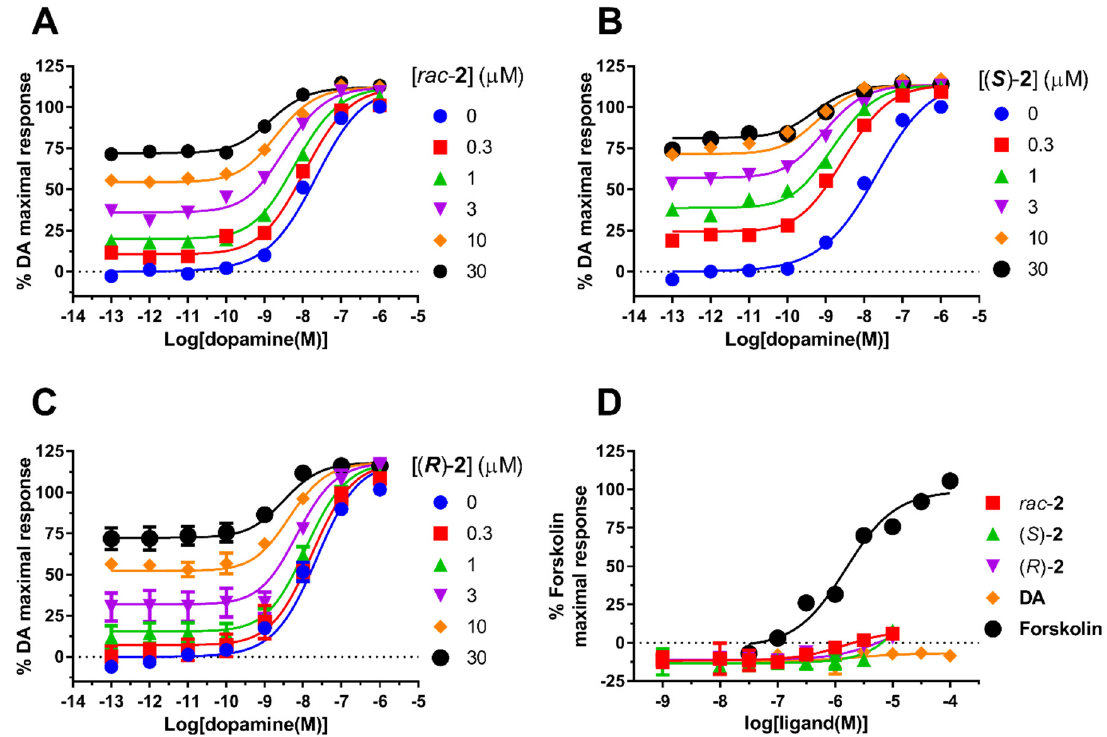
Figure 2. All compounds display allosteric pharmacology at the D 1 R in an assay measuring cAMP production using a BRET biosensor. rac - 2 ( A ), the enantioenriched S -isomer ( S )- 2 , ( B ), and the enantioenriched R -isomer ( R )- 2 , ( C ) act as an ago-PAMs, potentiating DA potency and exerting allosteric agonism. These data were fitted to an operational model of agonism to derive values of affinity, cooperativity with DA and intrinsic efficacy (see Table 1). Data are presented as mean ± S.D. from at least four separate experiments. ( D ) All compounds were assessed for their activity at non-hD 1 R/hD 2 R expressing FlpIn CHO-cells transfected with the BRET biosensor, demonstrating that compound activity is mediated through the D 1 /D 2 Rs. Data are presented as mean ± S.D. from at least four separate experiments.